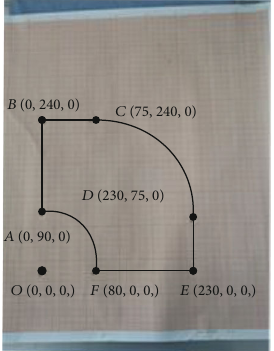
Figure 24: The position of each vertex in the coordinate